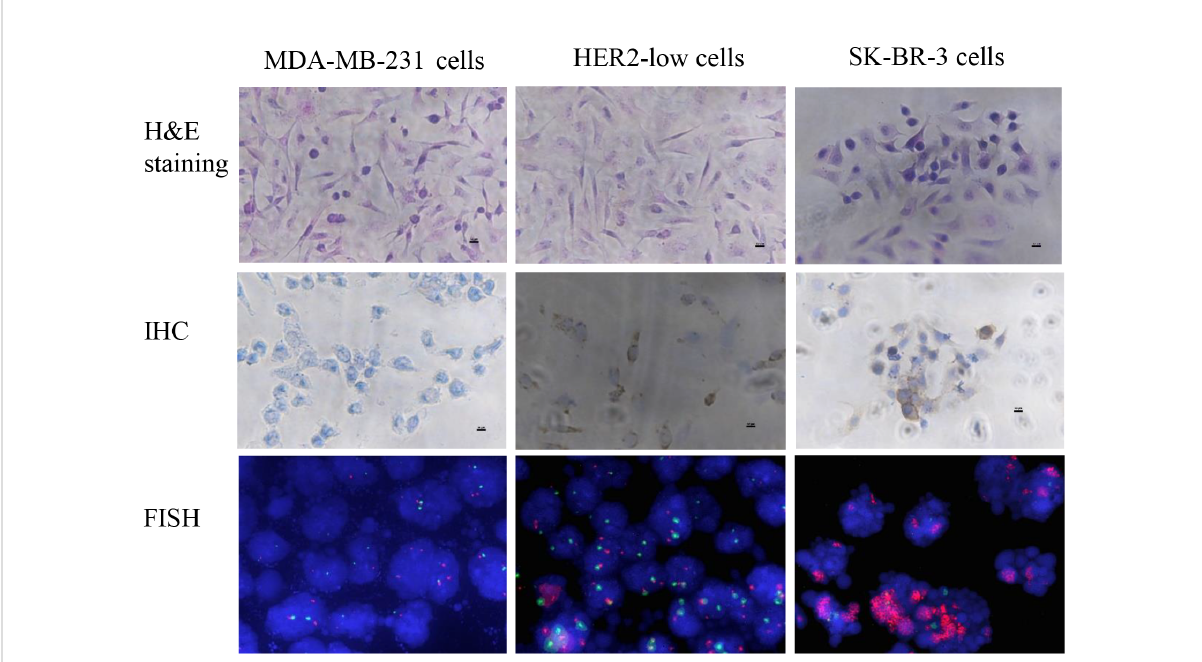
FIGURE 4 The cell slide evaluated that HER2-low cells can be detected by conventional detection methods. HE staining showed that the cell morphology was intact. IHC showed that MDA-MB-231 WT cell line had no staining and was negative. SK-BR-3 was brown-yellow, +++. HER2-low was moderately stained, denoted as ++. FISH showed that MDA-MB-231 WT cells had no ampli fi cation of HER2 (HER/CEP17 ratio was 1.057); the HER2 signal in SK-BR-3 was clustered and signi fi cantly ampli fi ed; HER2-low cells had no ampli fi cation of HER2 (HER/CEP17 ratio was 1.375).